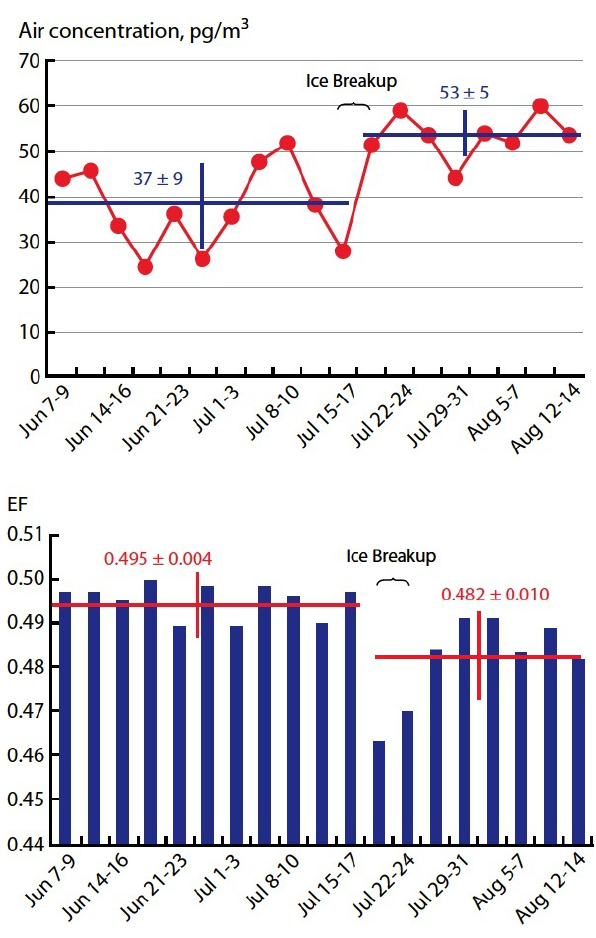
Fig. 7. Average air concentrations (top) and enantiomer fractions (bottom) at Resolute Bay before and after the seasonal ice melt, Jantunen et al. (2008). During winter/spring ice coverage, α -HCH in the air had a racemic composition (i.e. EF=0.5) but with the loss of ice cover in spring, the concentrations in the air rose considerably from the winter values, and the EF changed towards the signature of the surrounding waters Reported errors represent 1 standard de- viation based on method uncertainties. Picture modified according to AMAP